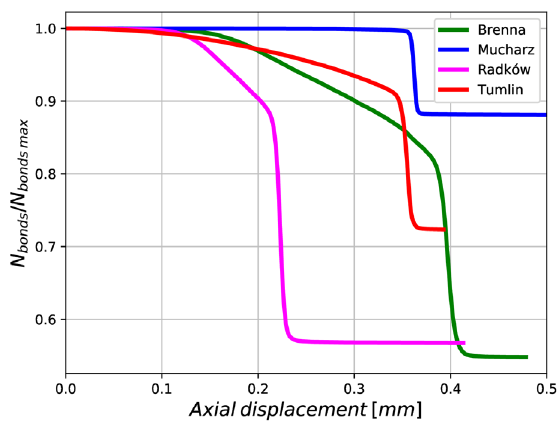
/ N (number of bonds bonds bonds max